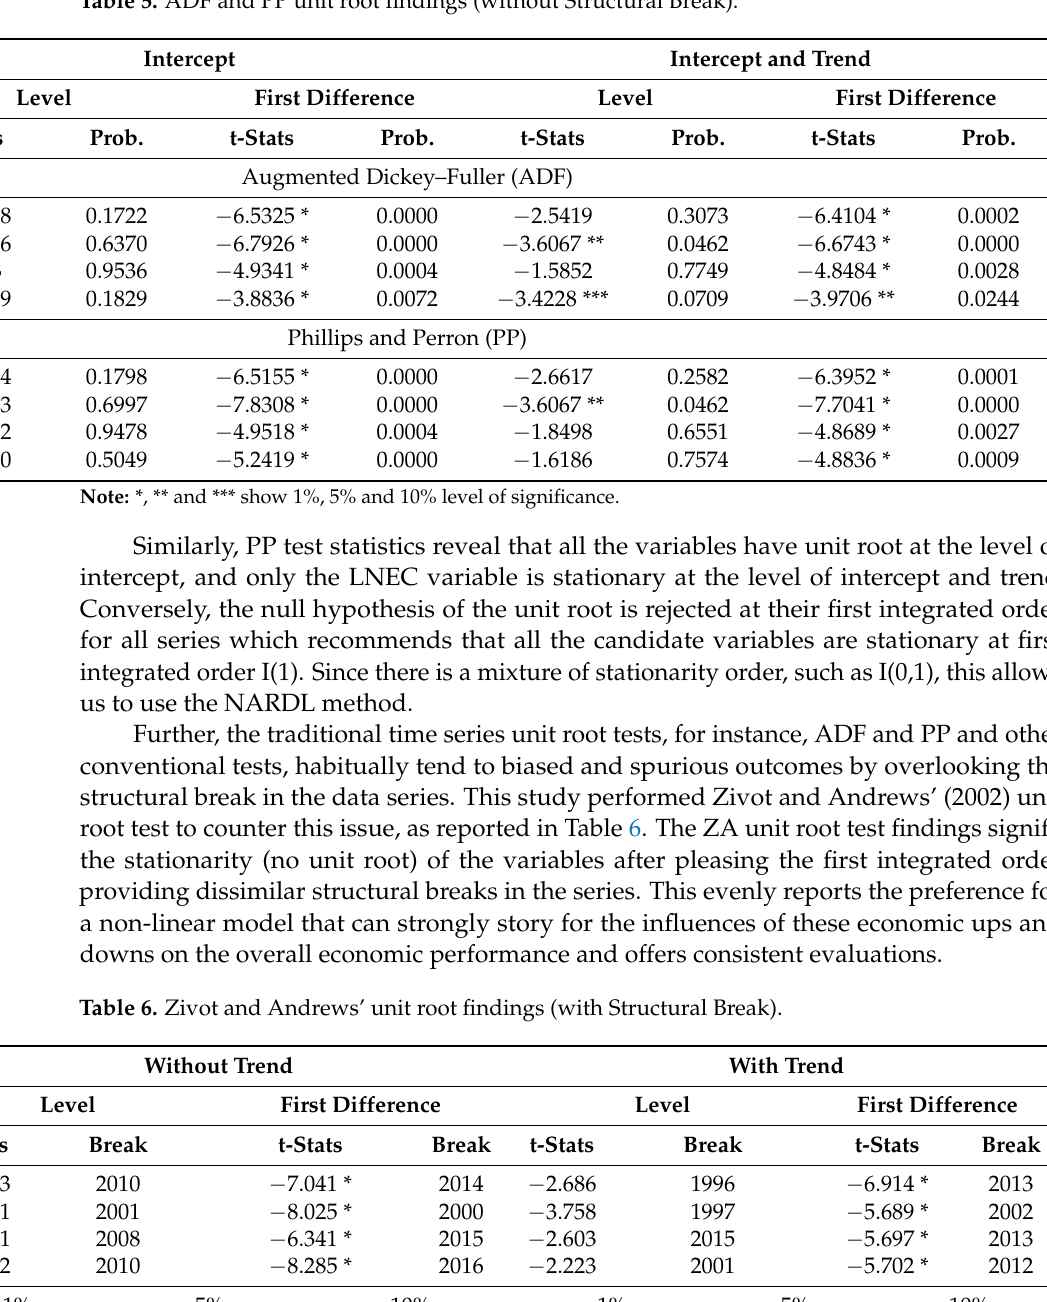
Table 5. ADF and PP unit root findings (without Structural Break).